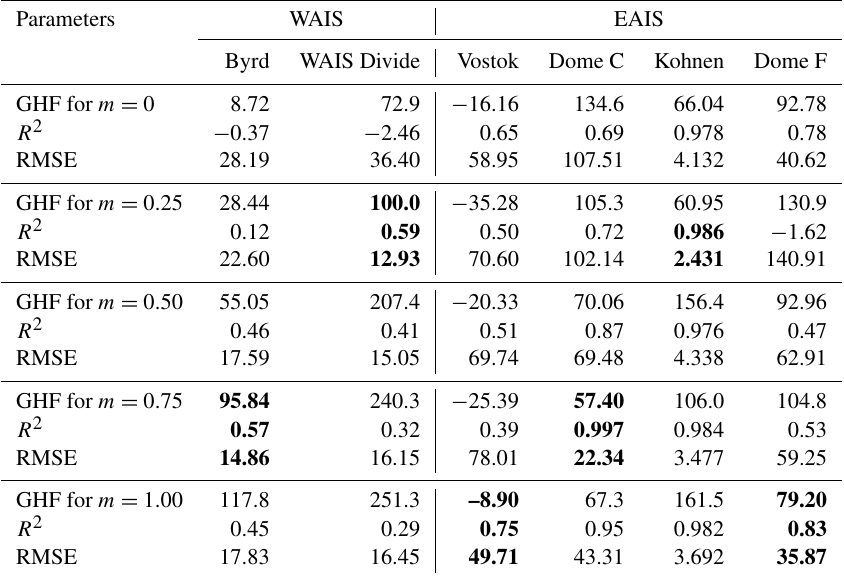
GHF values with the highest correlation factor and smallest RMSE are highlighted by